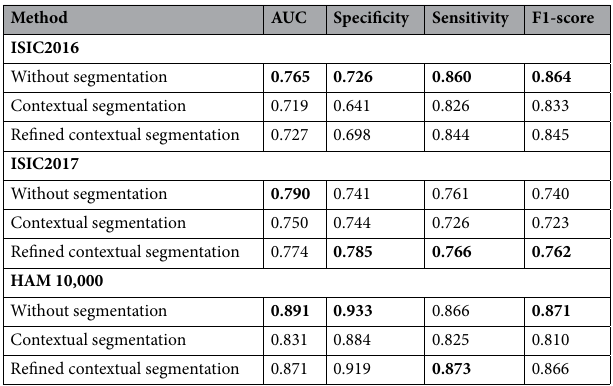
Table 4. Performance metrics for classification with dermatoscopic datasets.